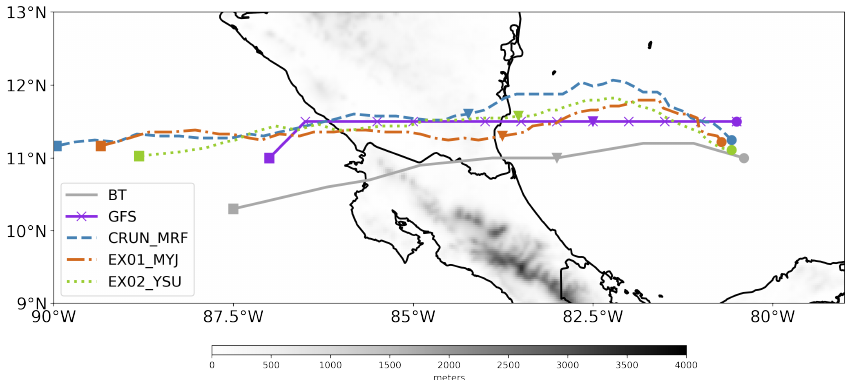
Figure 4. Hurricane Otto storm track for the period 1200 UTC 23 November 2016 to 1200 UTC 25 November 2016 from Best Track (solid line), GFS (solid line with crosses), CRUN_MRF (dashed line), EX01_MYJ (dash-dot line) and EX02_YSU (dotted line). The circle, triangle and square symbols identify the 1200 UTC from 23 to 25 of November 2016. CRUN_MRF, EX01_MYJ, and EX02_YSU are: the control-run using the Medium Range Forecast, the Mellor-Yamada-Janjic and the Yonsei University schemes, respectively. The grey shades represent topography from the 3-km